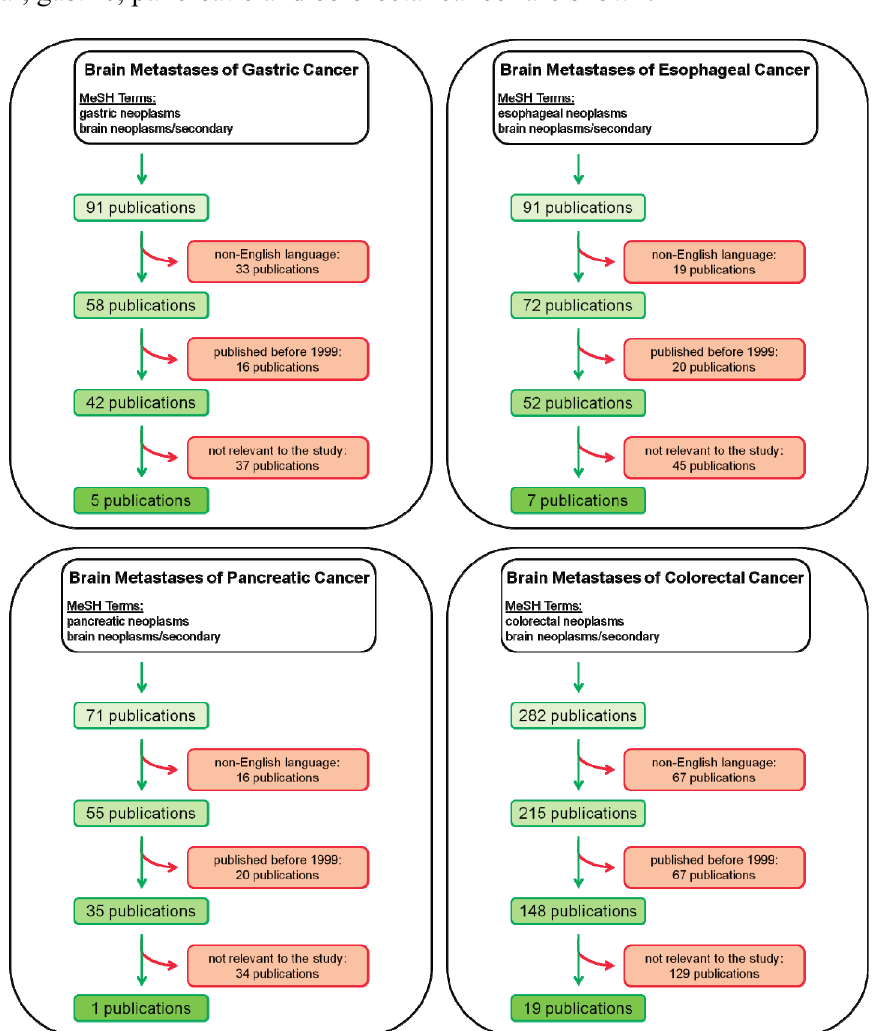
Figure 1. Flow charts of the literature search are provided. The search terms for the Medline query as well as the numbers of publications included and excluded for esophageal, gastric, pancreatic and colorectal cancer are